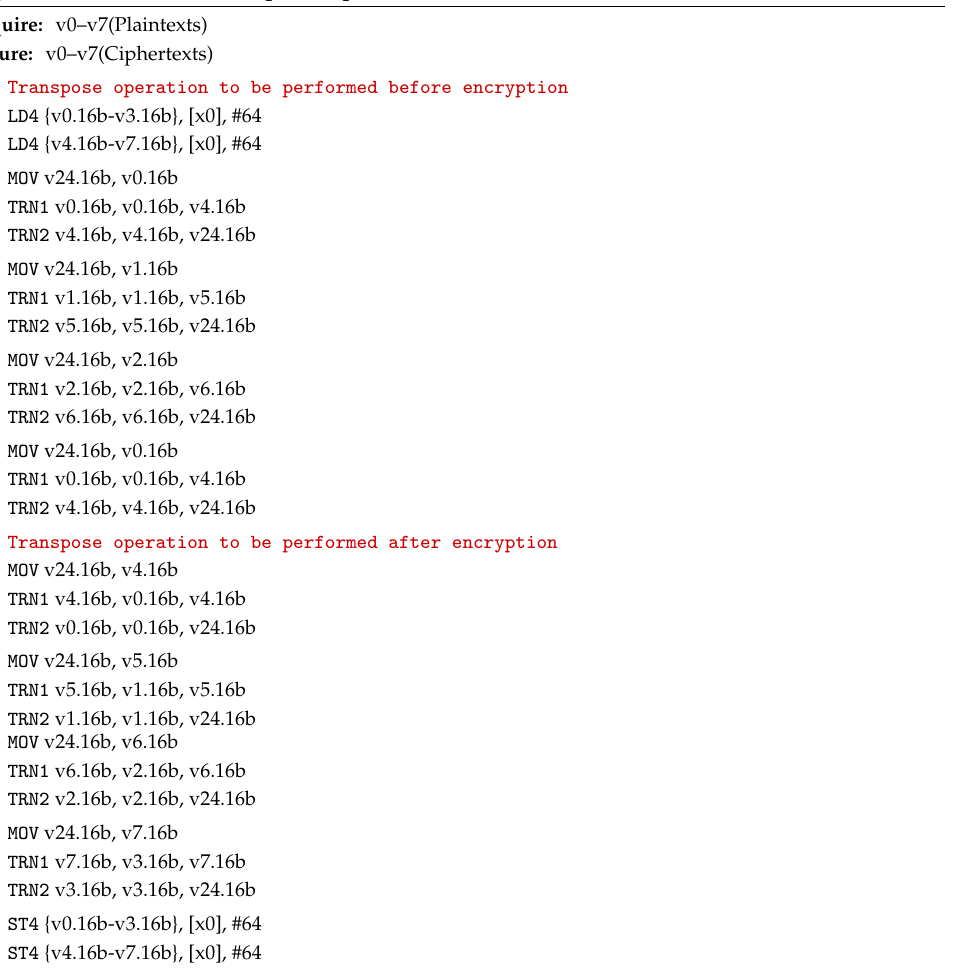
Algorithm 2 Efficient Transpose Operation for